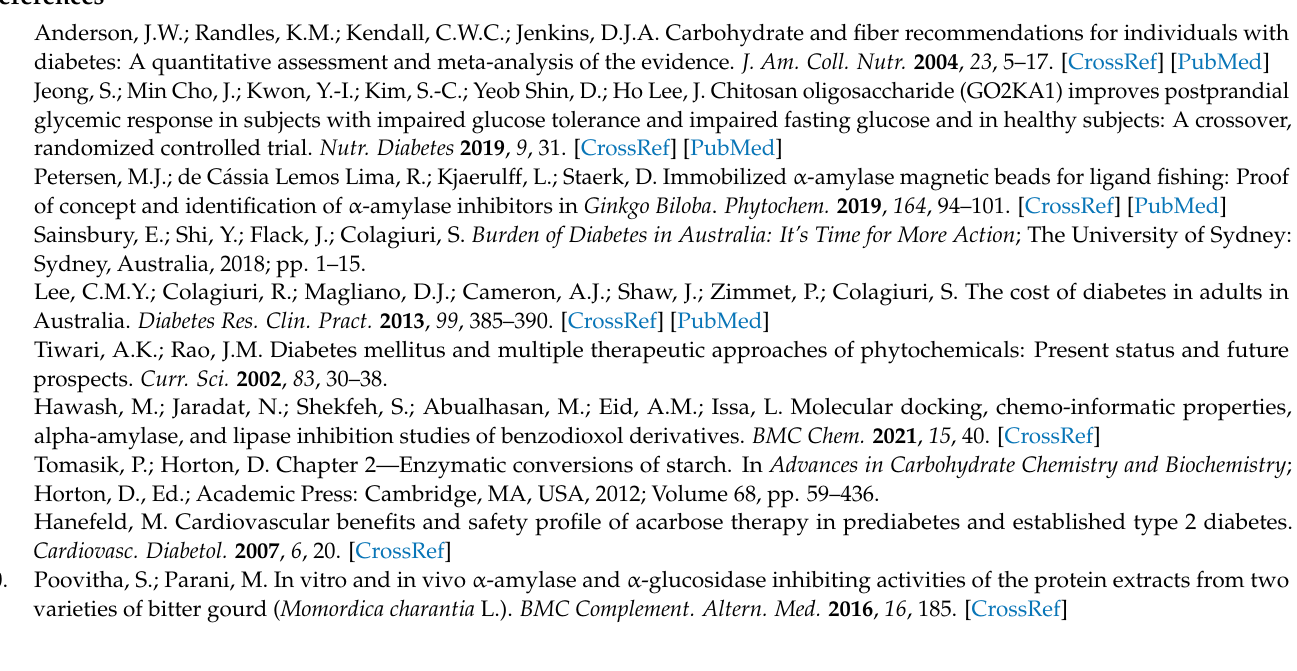
Figure S2: 13 C Spectrum of 1 in MeOH- d 4 ; Figure S3: HSQC Spectrum of 1 in MeOH- d 4 ; Figure S4: gCOSY Spectrum of 1 in MeOH- d 4 ; Figure S5: HMBC Spectrum of 1 in MeOH- d 4 ; Figure S6: 1 H Spectrum of 2 in MeOH- d 4 ; Figure S7: 13 C Spectrum of 2 in MeOH- d 4 ; Figure S8: HSQC Spectrum of 2 in MeOH- d 4 ; Figure S9: gCOSY Spectrum of 2 in MeOH- d 4 ; Figure S10: HMBC Spectrum of 2 in MeOH- d 4 ; Figure S11: 1 H Spectrum of 3 in MeOH- d 4 ; Figure S12: 13 C Spectrum of 3 in MeOH- d 4 ; Figure S13: HSQC Spectrum of 3 in MeOH- d 4 ; Figure S14: gCOSY Spectrum of 3 in MeOH- d 4 ; Figure S15: HMBC Spectrum of 3 in MeOH- d 4 ; Figure S16: 1 H Spectrum of 4 in MeOH- d 4 ; Figure S17: 13 C Spectrum of 4 in MeOH- d 4 ; Figure S18: HSQC Spectrum of 4 in MeOH- d 4 ; Figure S19: gCOSY Spectrum of 4 in MeOH- d 4 ; Figure S20: HMBC Spectrum of 4 in MeOH- d 4 ; Figure S21: 1 H Spectrum of 5 in CHCl 3 - d ; Figure S22: 13 C Spectrum of 5 in CHCl 3 - d ; Figure S23: HSQC Spectrum of 5 in CHCl 3 - d ; Figure S24: gCOSY Spectrum of 5 in CHCl 3 - d ; Figure S25: HMBC Spectrum of 5 in CHCl 3 - d ; Figure S26: 1 H Spectrum of 6 in MeOH- d 4 ; Figure S27: 13 C Spectrum of 6 in MeOH- d 4 ; Figure S28: HSQC Spectrum of 6 in MeOH- d 4 ; Figure S29: gCOSY Spectrum of 6 in MeOH- d 4 ; Figure S30: HMBC Spectrum of 6 in MeOH- d 4 ; Figure S31: Two-dimensional diagrams showing non-covalent interactions of 1 – 9 and acarbose ( 10 ) with α -glucosidase (2ZQ0); Figure S32: Two- dimensional diagrams showing non-covalent interactions of 1 – 9 and acarbose ( 10 ) with α -amylase (2QV4); Figure S33: Two-dimensional diagrams showing non-covalent interactions of 1 – 9 and orlistat ( 11 ) with lipase